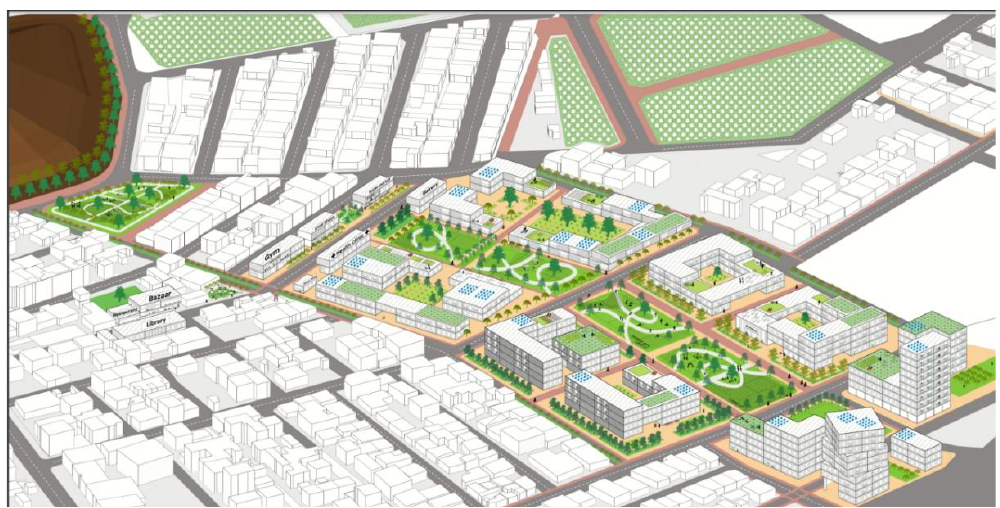
Figure 19 Realization of stake holders’ proposals developed during game